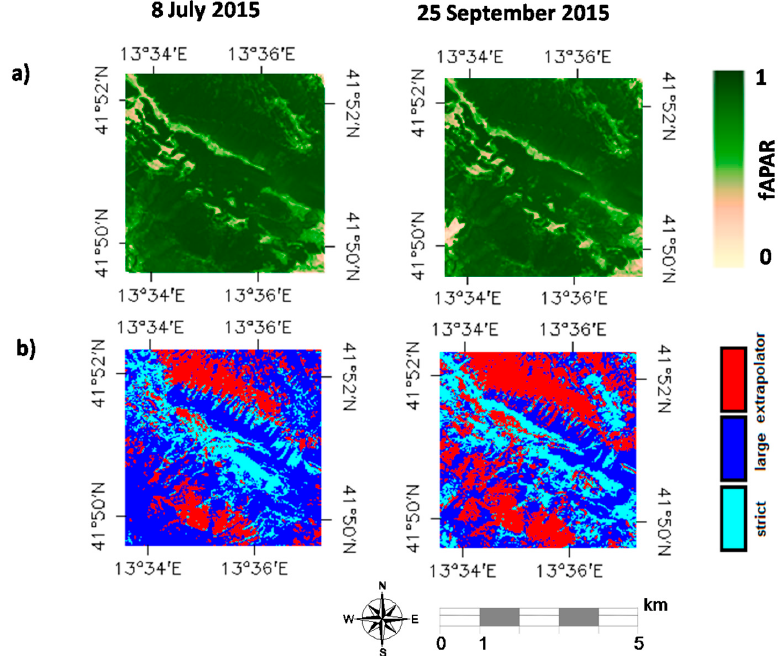
Figure 7. ( a ) Ground-based high-resolution maps (5 km × 5 km) of instantaneous black-sky canopy fAPAR at 10:00 a.m. over the Collelongo site (Italy). ( b ) Convex Hull test over 5 km × 5 km: clear and dark blue correspond to the pixels belonging to the ‘strict’ and ‘large’ convex hulls, respectively. Red corresponds to the pixels for which the transfer function behaves as an extrapolator. Left: First field campaign (8 July 2015). Right: Second field campaign (25 September 2015).